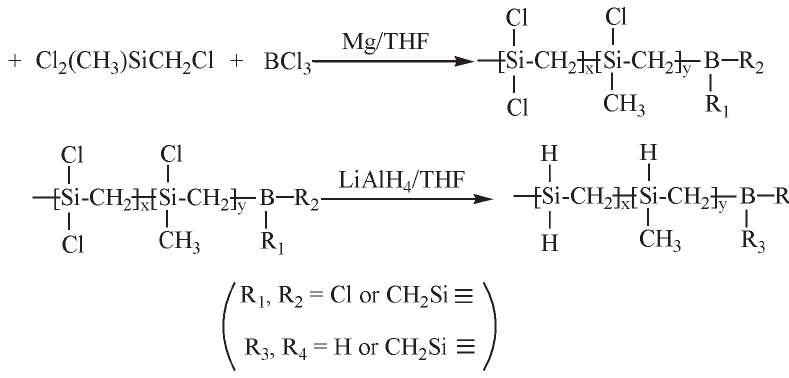
Scheme 1: Synthesis of HPBCS via monomer